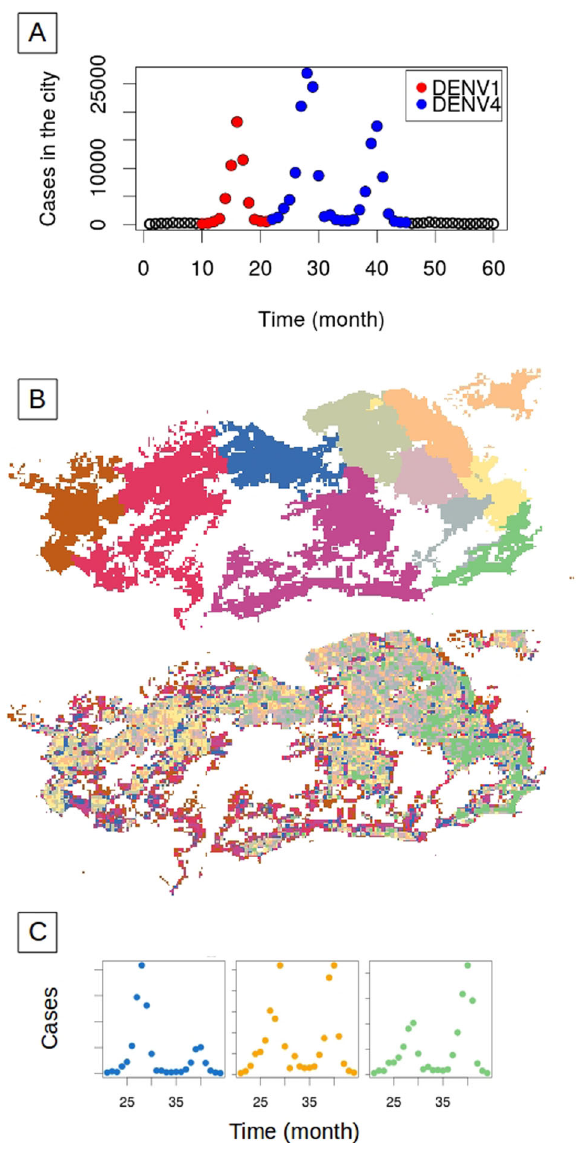
Fig. 1 Dengue incidence patterns in Rio de Janeiro city. A Total monthly cases of dengue reported in the city from January 2010 to December 2014. Red and blue dots correspond, respectively, to outbreaks with two different dominant serotypes, DENV1 and DENV4, with the latter making its fi rst emergence in Rio de Janeiro. Black circles indicate seasons without outbreaks and only a small number of cases. B The maps illustrate the geography of the city when 250 m by 250 m units are aggregated into 10 strata by administrative regions (top) or population density — number of individuals in an area of 250 m by 250 m — (bottom) (see Supplementary Fig. 6 for the population density map with the scale reference). C Examples of three different possible patterns for the relative size of the peaks and therefore, peak ratio, for DENV4 incidence in three of the 10 administrative regions shown in the upper map in ( B ). The colors indicate the corresponding regions in this